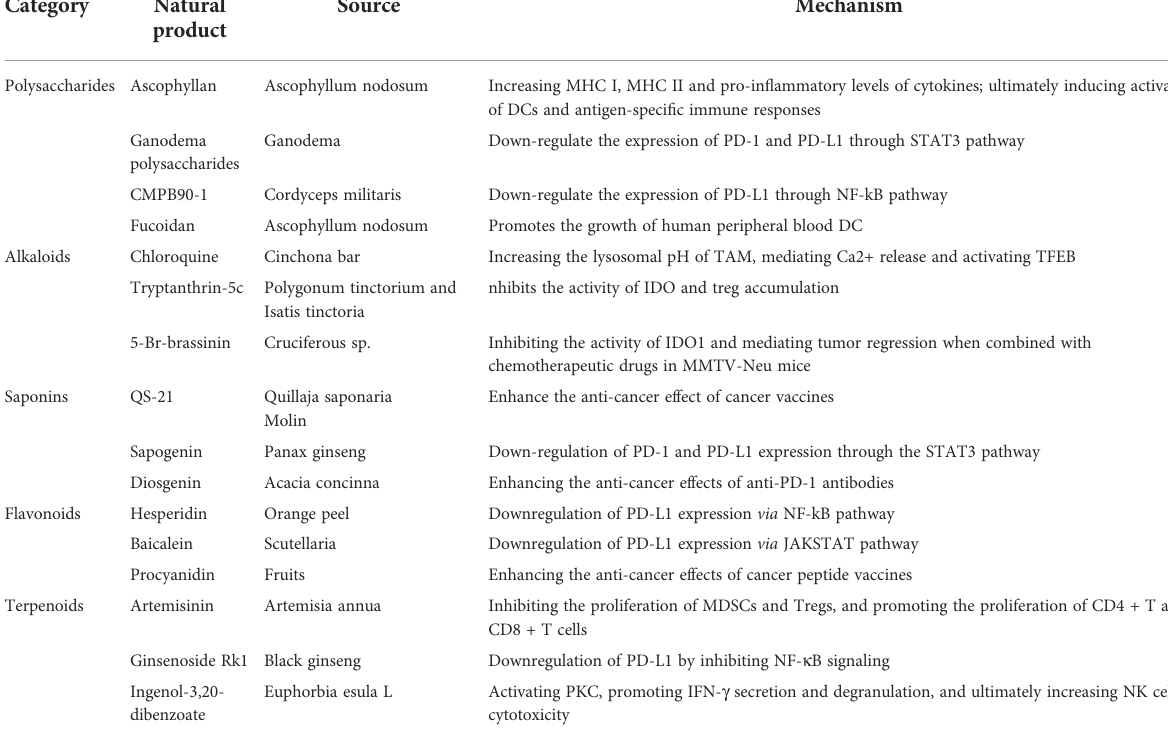
TABLE 1 Representative natural products with immuno-tumor therapeutic effects.